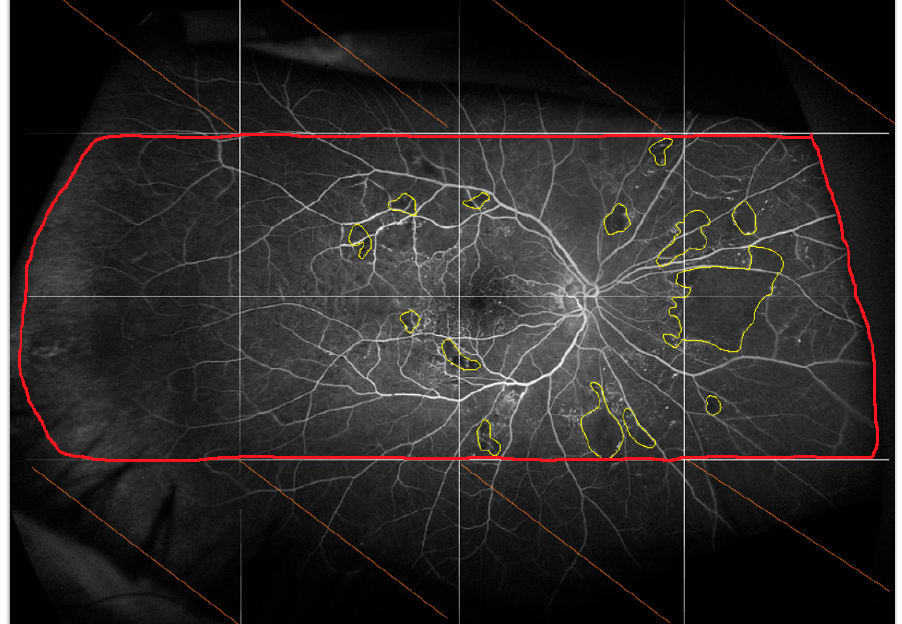
Figure 2. Fluorescein angiogram of the right eye acquired 45 sec after dye injection at baseline. The image was aligned with the image obtained at M12 and then divided into 16 blocks to facilitate the identification of ischemia. Only the blocks analyzable at baseline and M12 were analyzed.